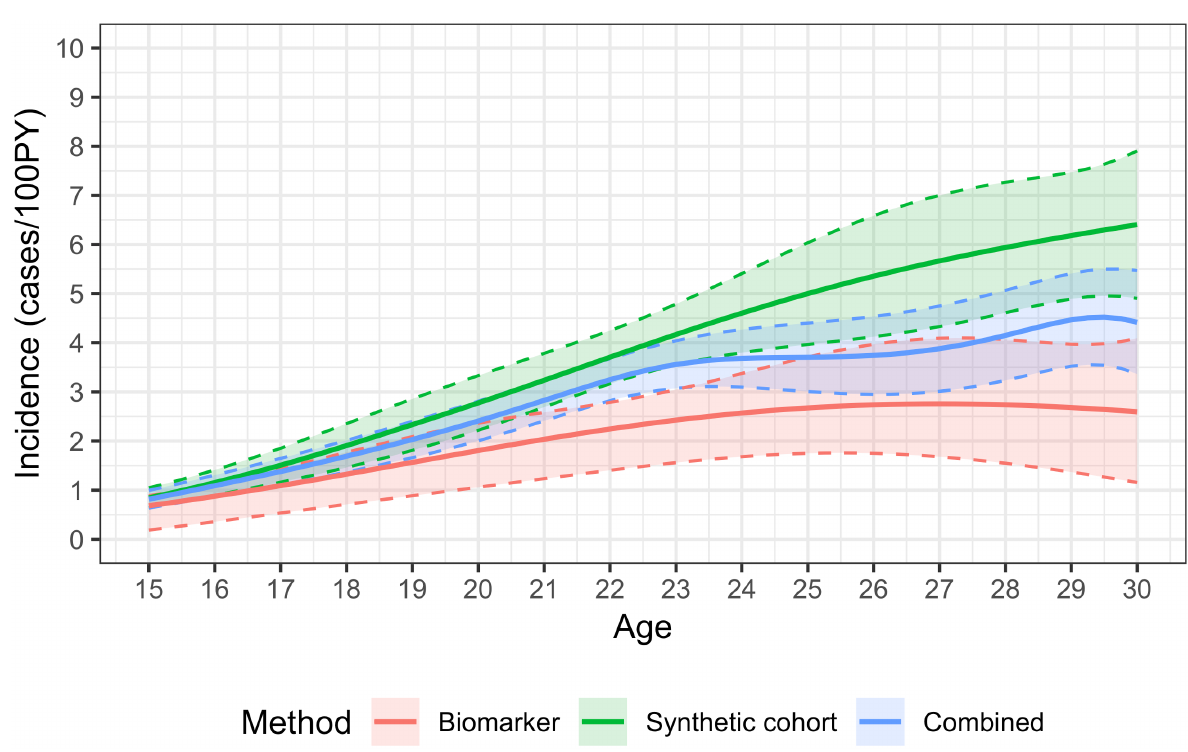
Fig 1. HIV incidence by age in males and females aged 15-30, using the synthetic cohort, recency biomarker and combined methods.